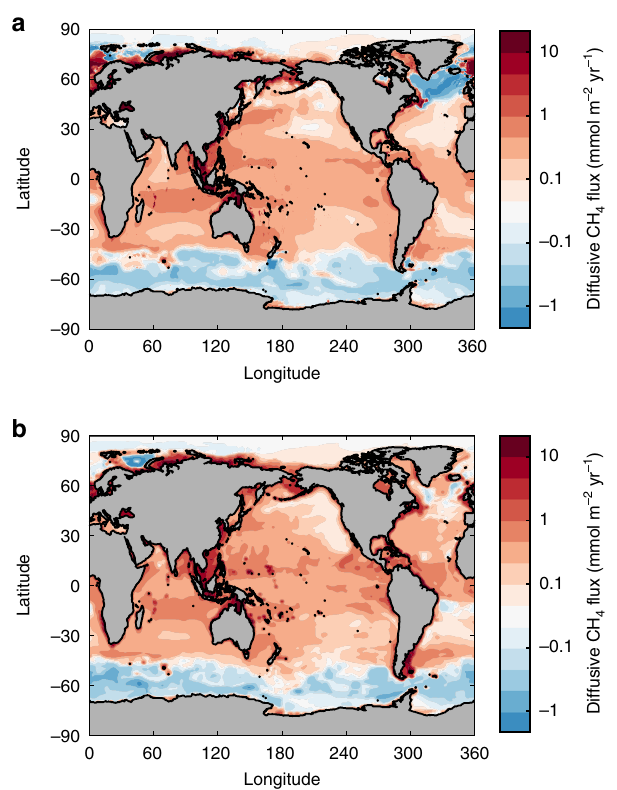
Fig. 3 Diffusive ocean – atmosphere CH 4 fl ux. a Annual diffusive CH 4 emissions, averaged across an ensemble 100,000 individual calculations using the arti fi cial neural network mapping method. b Same as a , but using the random regression forest mapping